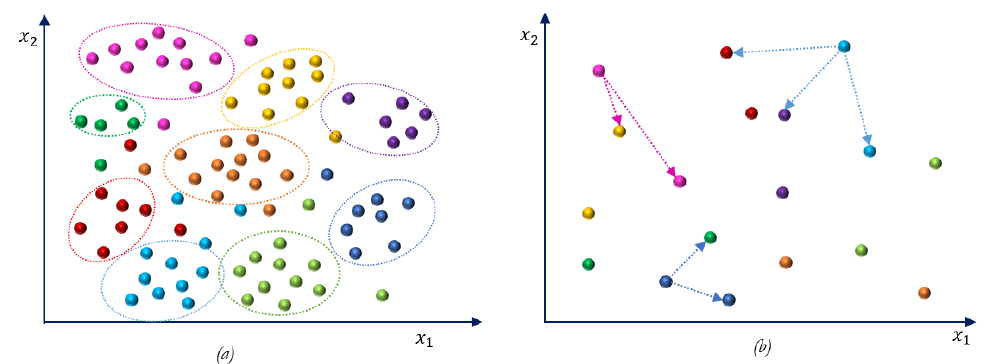
Figure 2. Scheme of the distribution of MOT ( a ) and Re-Id ( b ) samples representations in a bidimensional feature space. Each color renders an identity. In MOT domain ( a ), samples can be easier clustered, although detections after long-term occlusion or fast-moving camera platforms can cause the dispersion of some samples. The number of samples of each identity is variable. In the Re-Id domain ( b ), the strong intra-class variations and inter-class ambiguities make the distance from one sample to its match pair similar or even larger than to different individuals’